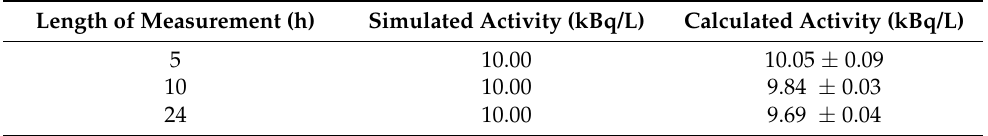
Table 8. The estimate of 90 Sr activity for increasing lengths of measurement and therefore